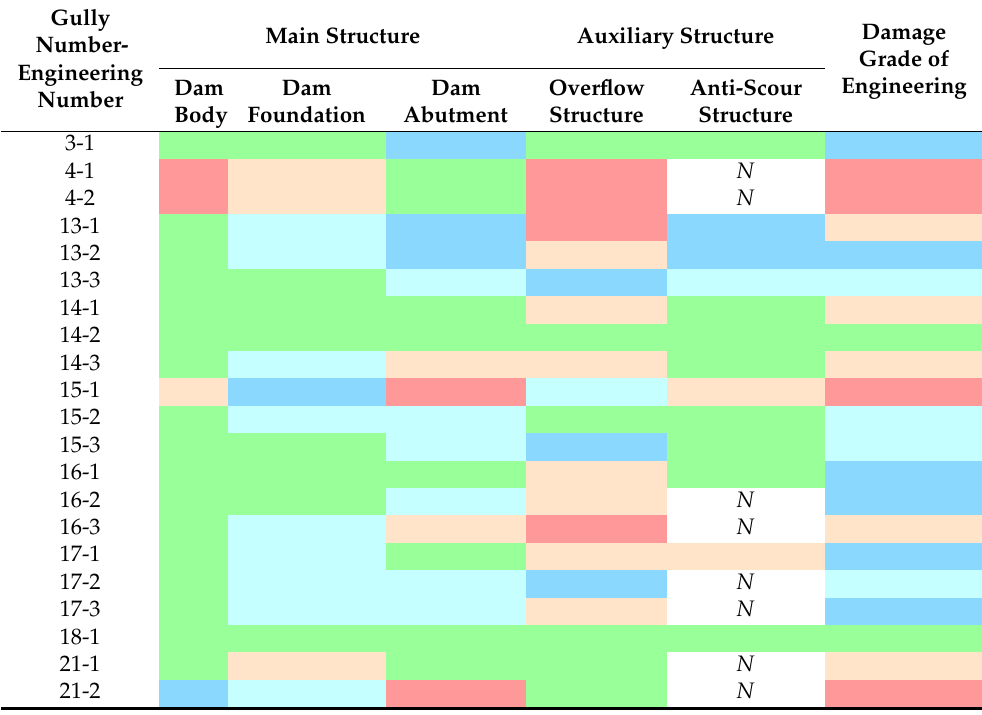
Table 4. Statistics of damage grade division of check dam. (The legend of damage grade is the same as Figure 5).